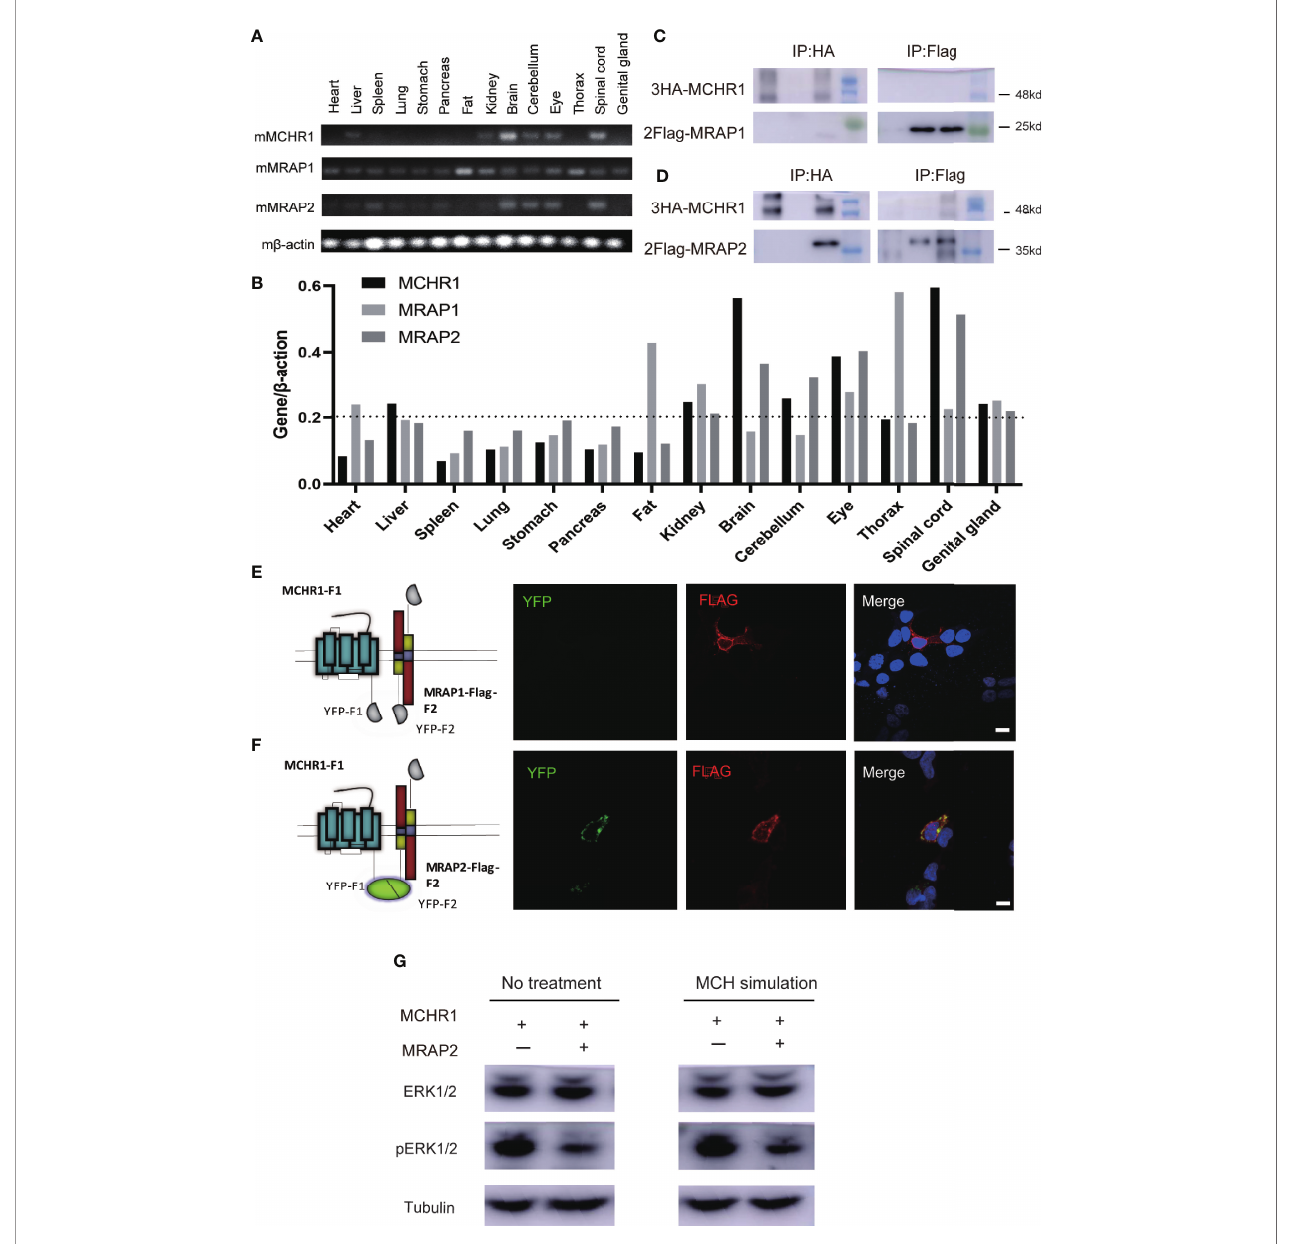
FIGURE 2 | Protein interaction of MCHR1 with MRAP2 but not MRAP1. (A) Tissue distribution of MCHR1, MRAP1, and MRAP2 tested by RT-PCR. b -actin was used as an internal control. (B) Expression abundance analysis of MCHR1, MRAP1, and MRAP2 in 14 mouse tissues. (C, D) Co-IP analysis of the interaction between 3HA-MCHR1 and 2Flag-MRAP1 (C) or 2Flag-MRAP2 (D) . The numbers on the right indicate molecular weight of marker band on the right (kd). (E, F) MCHR1-F1 co-localizes with MRAP1-Flag-F2 or MRAP2-Flag-F2 in live cells. YFP fl uorescence is exhibited in green (left panel). MRAP1 or MRAP2 in the same cells detected with anti-Flag antibody and secondary anti-mouse Alexa594 is shown in red (middle panel). DAPI were applied to stain cell nuclei and shown in blue in merge fi gures (right panel) (scale bars, 10 m m). (G) Western blot for ERK1/2 and pERK1/2, and Tubulin is used as reference. The sample order: MCHR1, MCHR1 +MRAP2, MCHR1 with MCH simulated, MCHR1+MRAP2 with MCH simulated (from left to